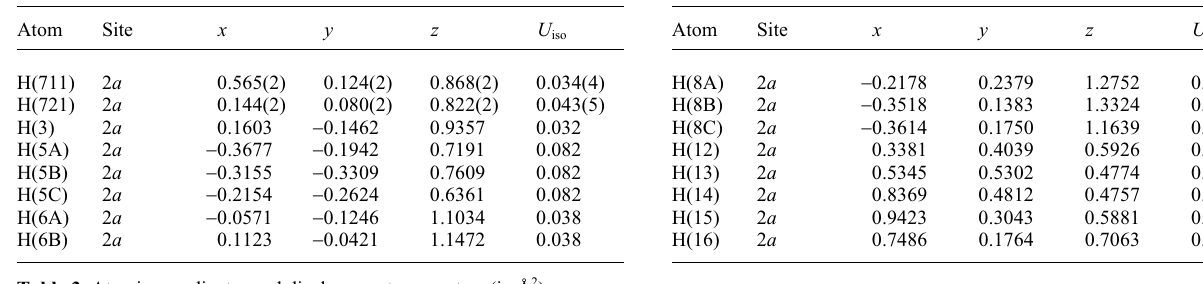
Table 2. Atomic coordinates and displacement parameters (in Å 2 ) .